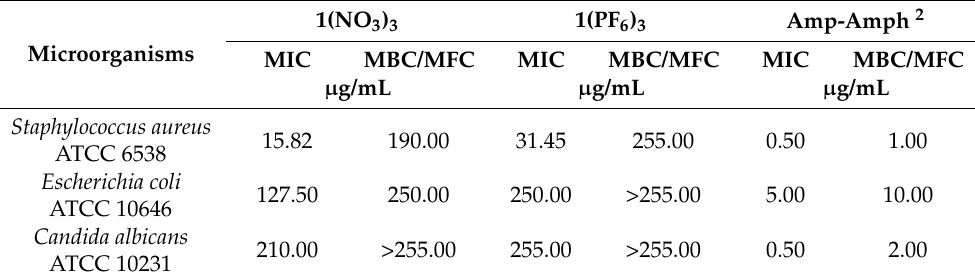
1 Values are obtained as the average of three measurements. 2 Amp-Amph: ampicillin, amphotericin B, antibiotic